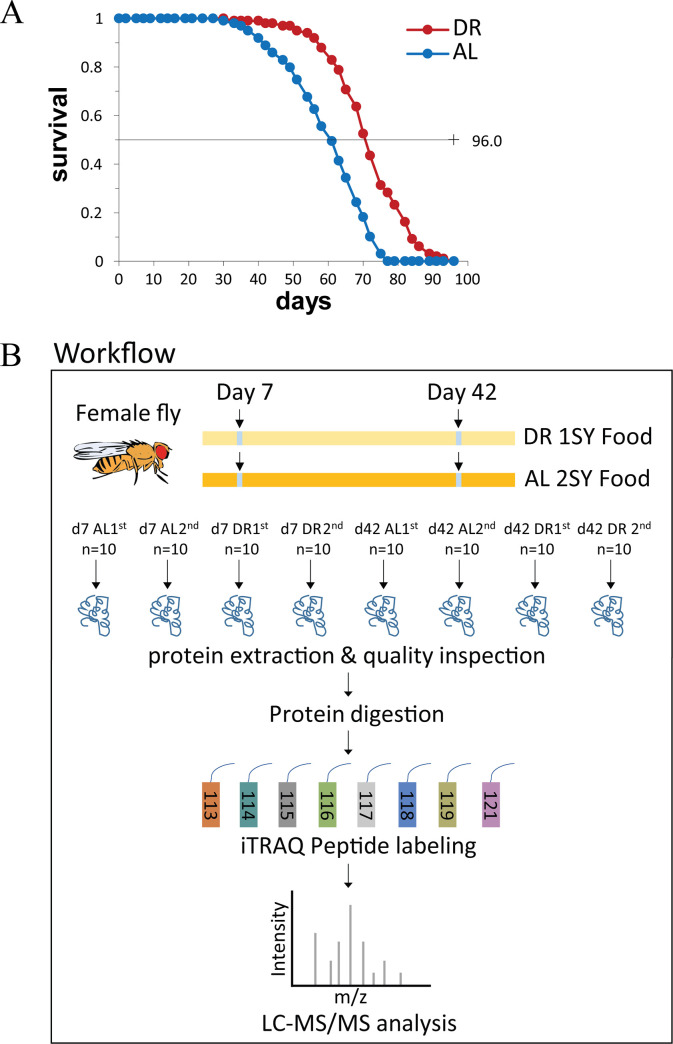
Lifespan curve and workflow of proteome sequence.(A) DR extends the lifespan in fruit flies. Curve of lifespan, DR (red, 1SYA food), AL (blue, 2SYA food). n = 100, p≤0.01. (B) Workflow from sample collection to mass spectrometry data acquisition. Details can be found in methods.